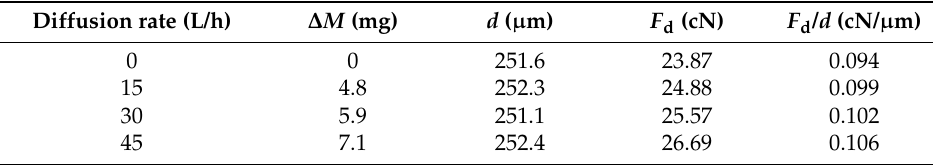
Table 1. Effect of PANI coating amount on the characteristics of the treated yarns.